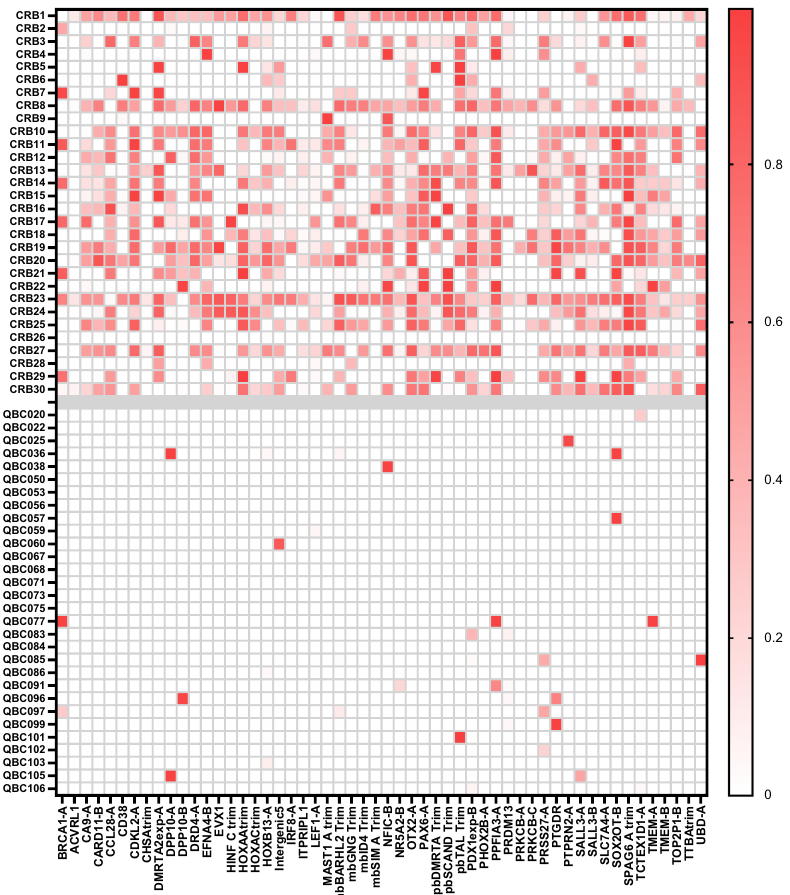
Fig. 9 Analysis of serum samples from metastatic TNBC patients. Thirty serum samples from metastatic TNBC patients (CRB1 – 30) and 30 new serum samples from healthy age-matched volunteers (QBC020 – 106) were analysed using mDETECT for the 54 optimal probes as described in Fig. 6. A heatmap of the fraction of methylated DNA for each probe is shown as described in Fig. maximum 72 o C, maximal differential 5 o C, primer size minimum 21 bp, optimal 28 bp, maximum 31 bp. Primers with at least two CpG residues in